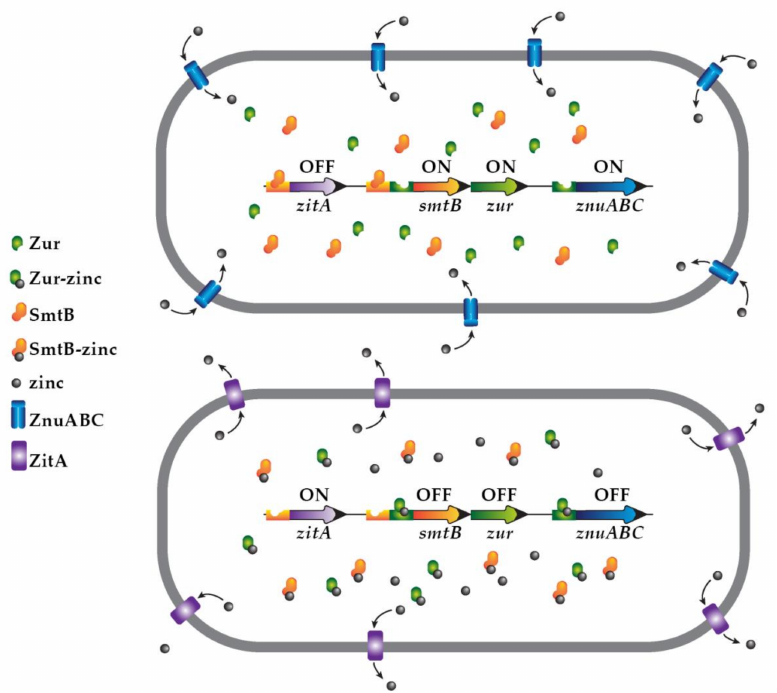
Figure 1. Mycobacterium smegmatis SmtB and Zur regulation of gene expression in response to the concentration of zinc. Model proposed by Goethe et al. [185]. The upper diagram shows a cell in an environment with low zinc concentration. In these conditions, SmtB is a homodimer that acts as a repressor of the expression of ZitA (zinc exporter). Binding of ZitA also facilitates expression of the smtB and zur genes. Zur depleted from zinc is unable to efficiently bind the Zur boxes upstream of znuABC (zinc importer) and smtB / zur . As a consequence, expression of ZnuABC and the regulators set up the cell to internalize zinc ions. The bottom diagram shows a condition where zinc ions are abundant; Zur binds the metal ions as a homodimer and binds the operators, turning off expression of smtB / zur and znuABC . SmtB loses affinity to the DNA, permitting high expression of ZitA, which facilitates export of zinc